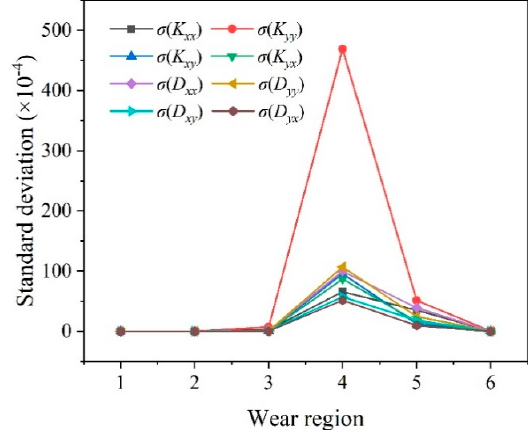
Figure 19. Standard deviation of the eight dynamic coefficients.